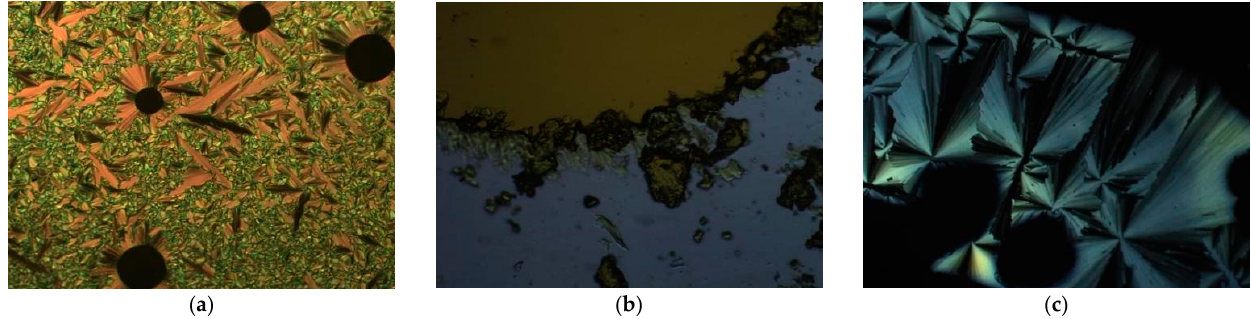
Figure 3. Optical textures of ( a ) the SmA phase formed by compound 3 -6 at 116 °C, ( b ) the cubic phase formed by 3 -10 with polarisers slightly uncrossed at 105 °C, ( c ) the Col h phase formed by compound 3 -12 at 154 °C.